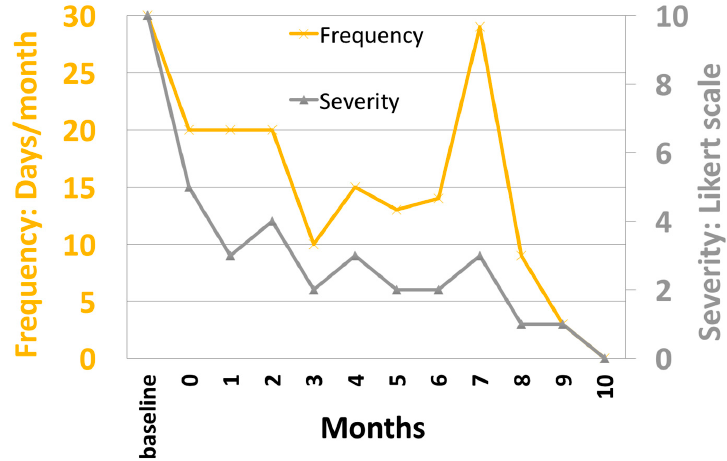
DBS. After month 10, the patient reported the occurrence of occasional bad dreams that were different from his typical nightmares in quality and